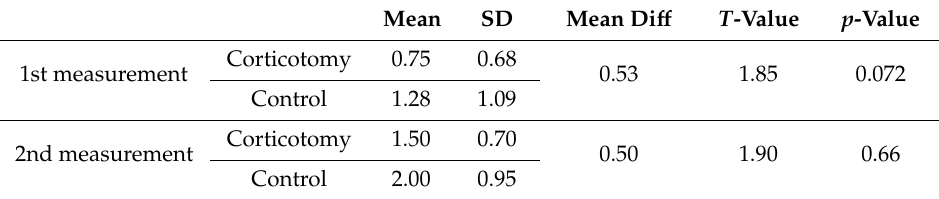
Table 3. Comparison of the premolar anchorage loss of the upper first molars in the partial corticotomy side and the control side (to the nearest 0.1 mm).